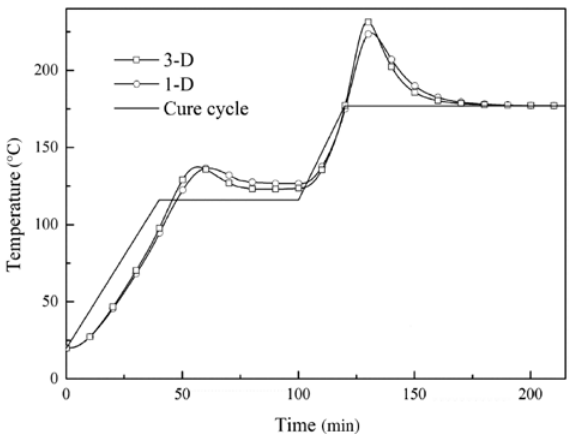
Figure 5: Temperature profile of the center point of the laminate.